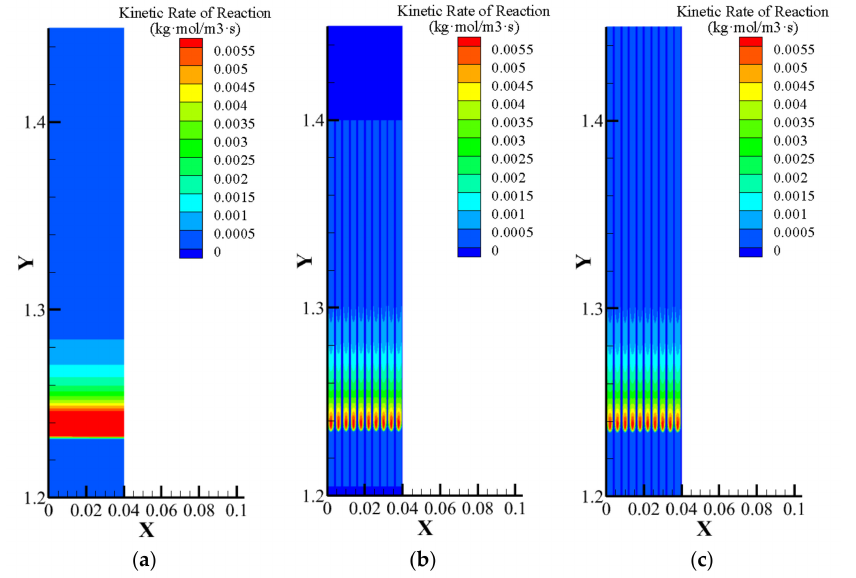
Figure 9. Reaction rate contour comparison of three models at 108 s with X CH rate of 700 m 3 /h. ( a ) VAM model; ( b ) Multi-scale model; ( c ) PSS model.